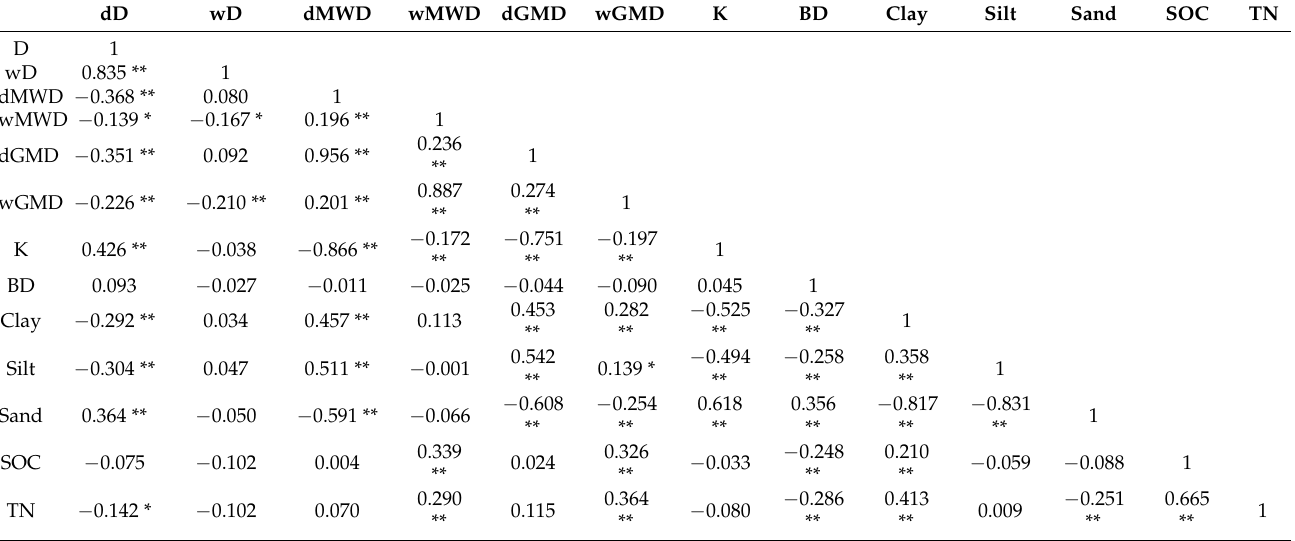
Table 2. Pearson correlations between the stability of soil aggregates, K values and soil properties.